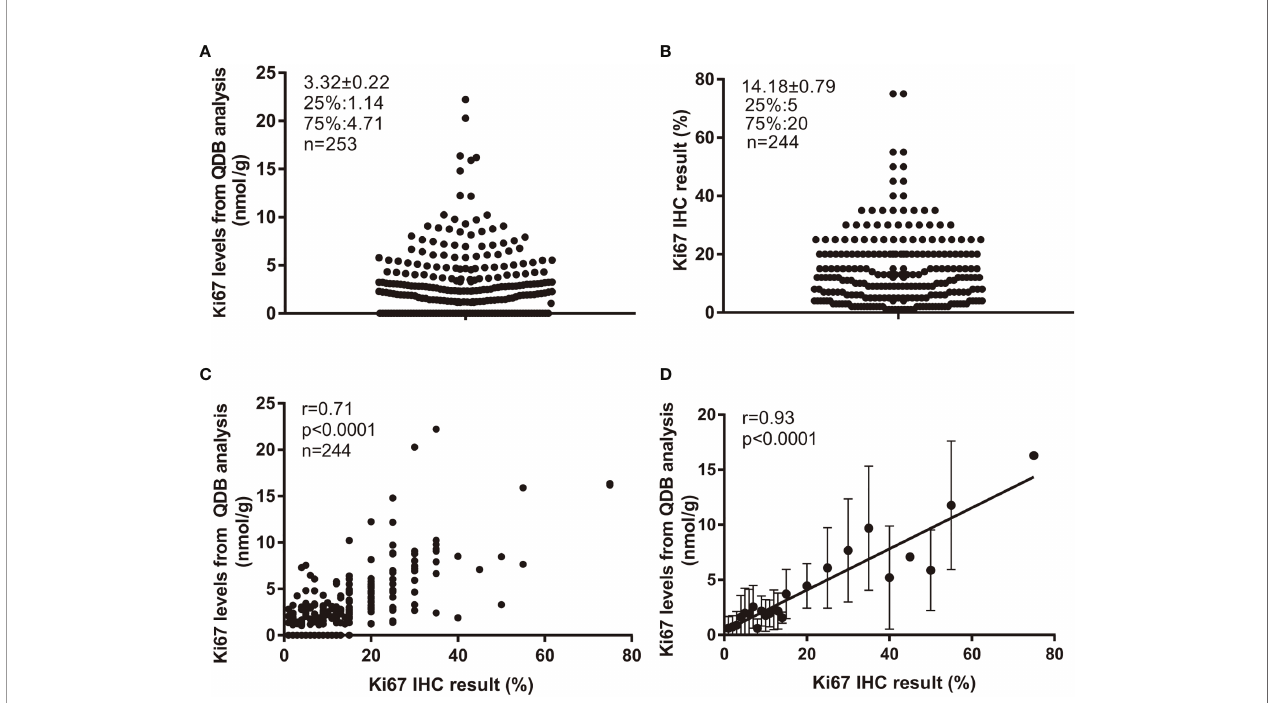
FIGURE 1 | Ki67 levels in 253 FFPE specimens and their correlations with Ki67 scores from IHC analysis. Total lysate was extracted from 2 × 15 m m FFPE slices individually, and 0.5 m g/specimen was used for QDB measurement using Mouse anti-Human Ki67 monoclonal antibody (MIB1). These specimens were also assessed with IHC analysis, with each IHC-stained slide assessed by three pathologists independently. The Ki67 scores used in the study were averages of three assessments. (A) Distribution of quantitatively measured Ki67 levels among these specimens. (B) Distribution of Ki67 scores from IHC analysis among 244 specimens. (C) Correlation analysis of the results from QDB and IHC analyses using Pearson ’ s correlation analysis with r = 0.71, p < 0.0001. (D) These specimens were subgrouped based on their respective Ki67 scores. The subgroup averages of the Ki67 levels from QDB measurements were used for correlation analysis with